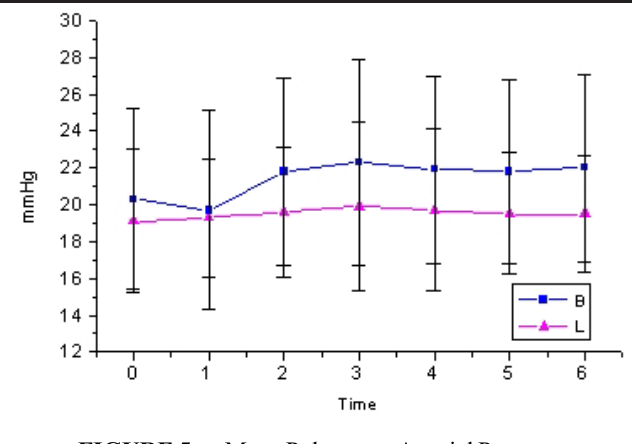
FIGURE 5 — Mean Pulmonary Arterial